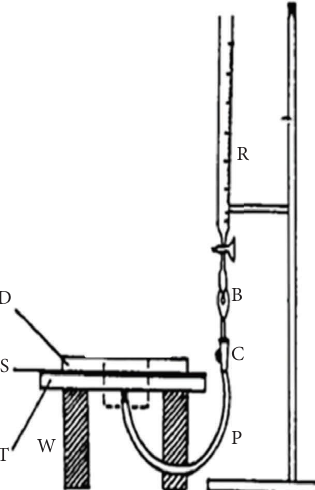
Figure 1: Apparatus assembly. B: dropper, C: wheel cock, D: Petri dish, S: TLC plate, P: plastic tubing, W: wooden blocks, T: glass plate, and R: